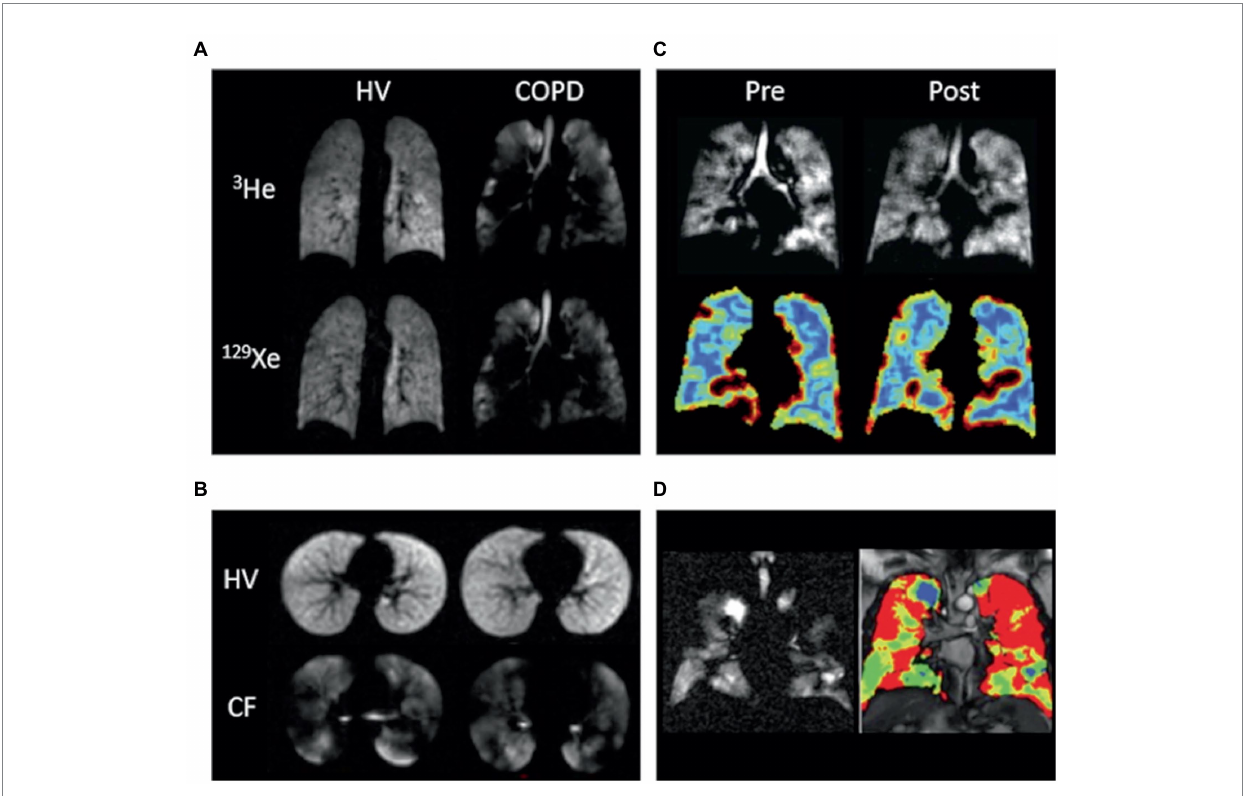
FIGURE 1 Ventilation imaging. (A) 3 He and 129 Xe ventilation images of a healthy non-smoker (HV) and a patient with chronic obstructive pulmonary disease (COPD). (B) 129 Xe ventilation images of a healthy 6-year-old (HV, FEV1 = 95%) and an 11-year-old with cystic fibrosis (CF, FEV1 = 102%). (C) 129 Xe ventilation images (top) and coefficient of variation maps (bottom; blue = low COV, red = high COV) of a patient with asthma pre-and post- bronchodilator inhalation. (D) 129 Xe ventilation image (left) and binning map (right; red = defect, yellow = low intensity, green = medium intensity, blue = high intensity) from an older patient with asthma (FEV1 = 53%). In this case, ventilation defect percentage is defined as the ratio of the number of red pixels to the total number of pixels in the whole lung × 100. Adapted with permission from